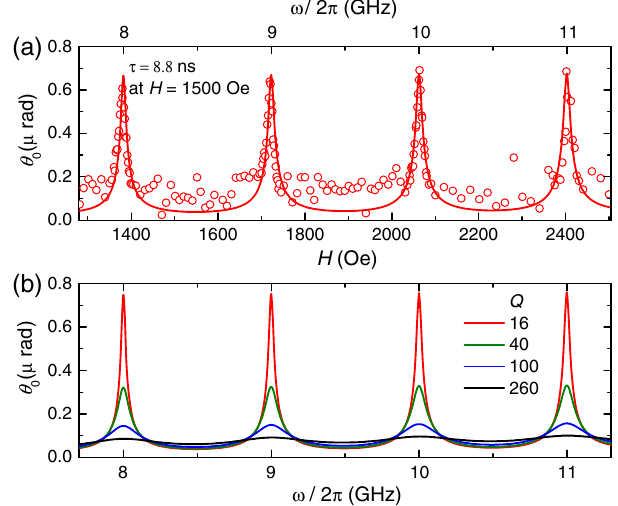
FIG. 3. Excitation of magnetization oscillation mode of high quality factor (mode B). (a) Measured precession amplitude in sample 2 vs magnetic field (open circles). The solid curve is calculated by solving Eq. (S11) (see Ref. [30]) with h ¼ 0 . 8 Oe, and α ¼ 0 . 005 ( τ ¼ 8 . 8 ns at H ¼ 1500 Oe) to fit the exper- imental data. (b) Calculated precession amplitude vs ω for modes of different quality factors [and therefore different values of τ : 0.6 ns (black line), 1.5 ns (blue line), 4 ns (green line), and 10 ns (red line) at H ¼ 1500 Oe]. Here, h ¼ 0 . 8